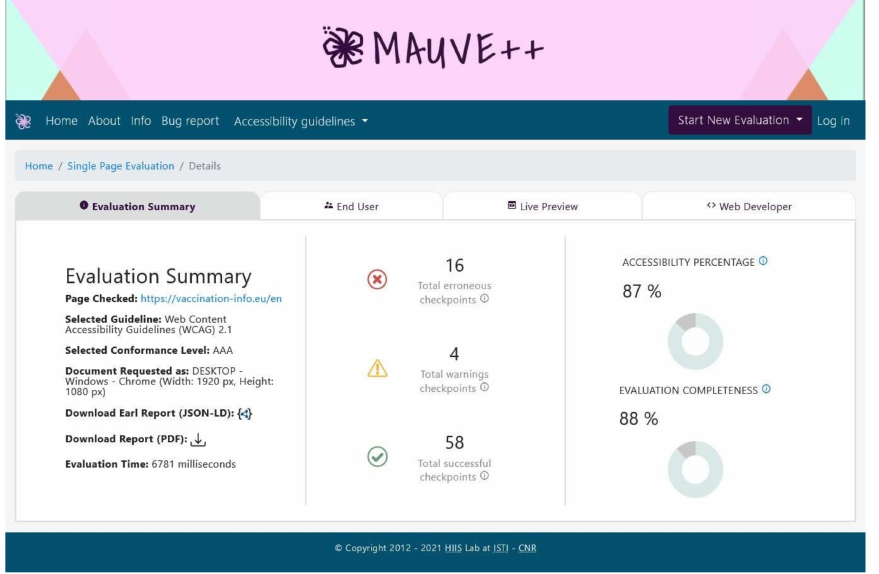
Figure 4. Screenshot of Mauve web accessibility testing